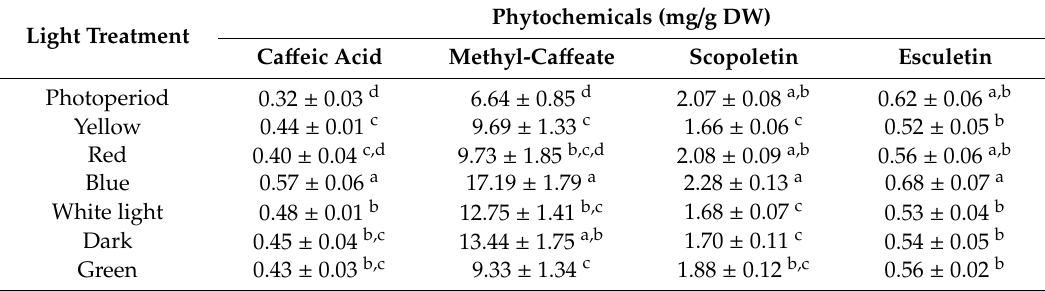
Figure 6. (a) Typical HPLC chromatogram showing the presence of caffeic acid (1), methyl-caffeate (2), esculetin (3), and scopoletin (4) in in vitro culture of S. xanthocarpum. (b) Correlation analysis (Pearson correlation coefficient, PCC) of the relation between caffeic acid, methyl-caffeate, scopoletin, and esculetin in in vitro culture of S. xanthocarpum subjected to different light treatments. Significance level: * p < 0.05, ** p < 0.01, *** p < 0.001. Table 1. Quantification of medicinally important phytochemicals in monochromatic light-treated callus cultures of S. xanthocarpum.